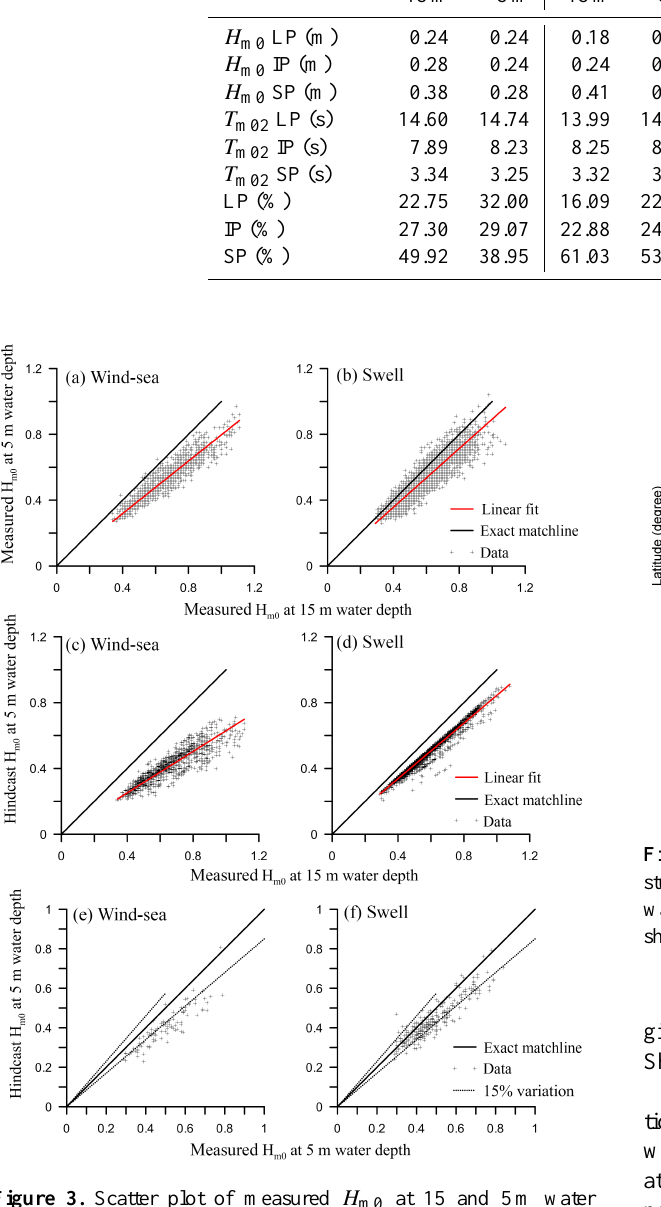
Figure 3. Scatter plot of measured H m0 at 15 and 5m water depth (a) for wind-sea and (b) for swell. (c) Scatter plot of hind- cast H m0 at 5m with the measured value at 15m water depth for wind-sea and (d) for swell. (e) Scatter plot of hindcast H m0 at 5m water depth with the measured data at 5m water depth for wind-sea and (f) for swell.